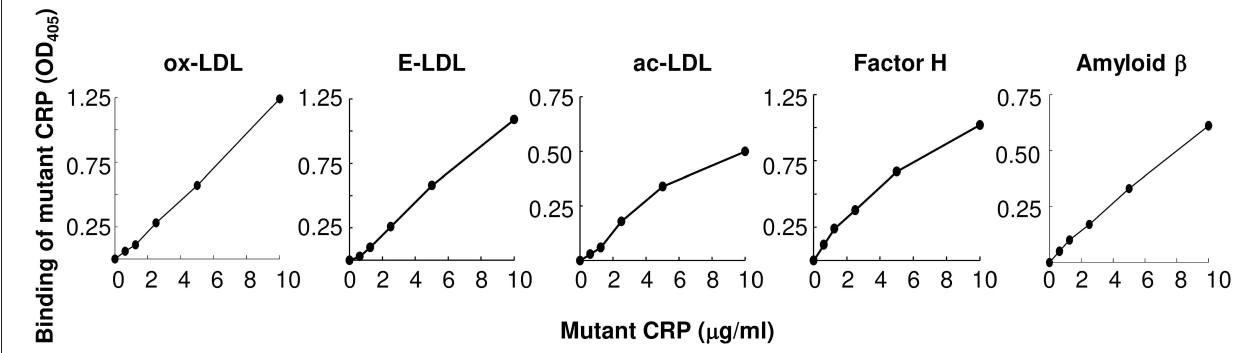
FIGURE 2 | Binding of F66A/T76Y/E81A mutant CRP to immobilized proteins including atherogenic LDL at physiological pH. Microtiter wells were coated with protein ligands as shown. After blocking the unreacted sites in the wells, mutant CRP diluted in TBS-Ca was added to the wells and incubated for 2h at 37 ◦ C. Bound mutant CRP was detected by using a rabbit anti-human CRP antibody and HRP-conjugated donkey anti-rabbit IgG. Color was developed and the OD was read at 405nm. A representative of three experiments are shown.